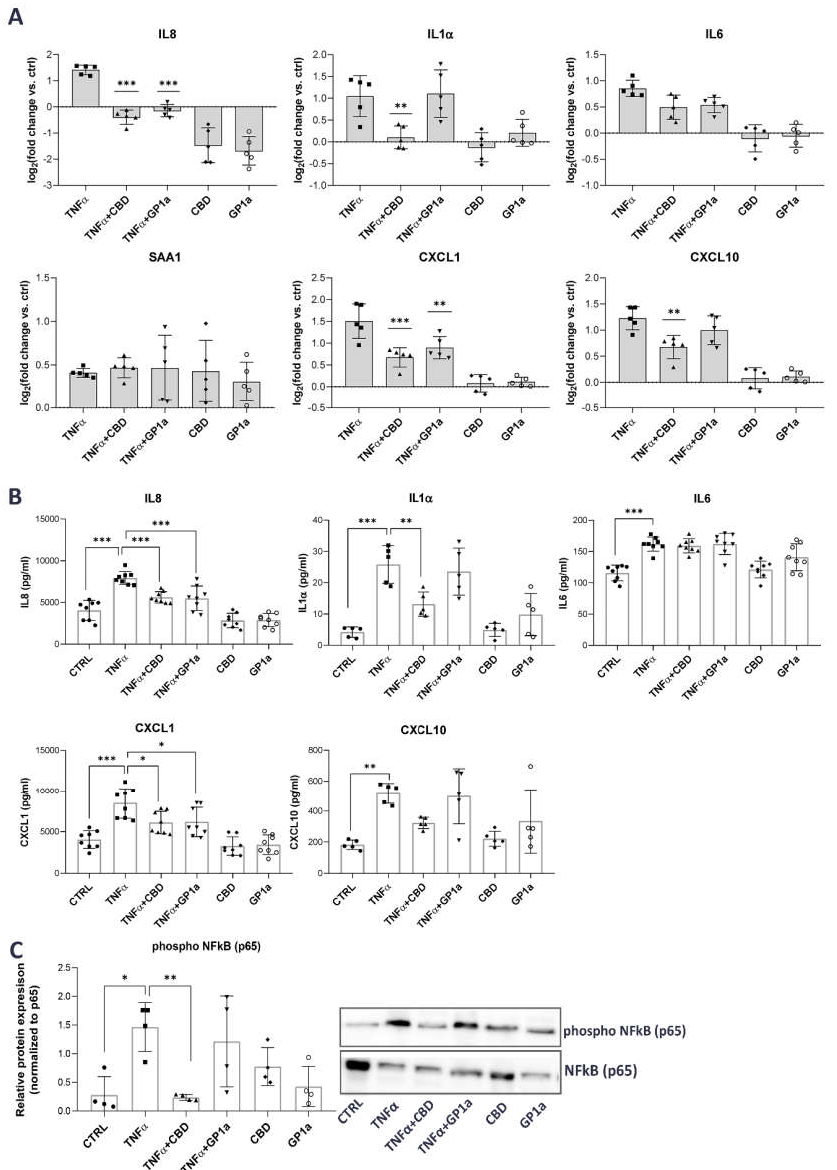
Figure 3. Anti-inflammatory effects of CBD in TNF α -stimulated SV-HUC1 cells. ( A ) mRNA expres- sion of IL8, IL1 α , IL6, SAA1, CXCL1 and CXCL10 in SV-HUC1 cells treated with TNF α (20 ng/mL) in the presence/absence of CBD (5 µ M) or GP1a (5 µ M) for 24 h determined by qPCR. Shown is mean ± SD log2 fold change vs. untreated control (set to 0) determined in five independent experi- ments. ** p < 0.01, *** p < 0.001 vs. TNF α -treated cells. ( B ) Protein levels of IL8, IL1 α , IL6, CXCL1 and CXCL10 released into the supernatants of SV-HUC1 cells treated with TNF α (20 ng/mL) in the presence/absence of CBD (5 µ m) or GP1a (5 µ M) for 24 h determined by ELISA. Shown is mean ± SD of concentrations determined in eight (IL8, IL6, CXCL1) or five (IL1 α , CXCL10) independent experi- ments. ( C ) Protein levels of phosphorylated NF κ B subunit p65 in SV-HUC1 cells treated with TNF α (20 ng/mL) in the presence/absence of CBD (5 µ M) or GP1a (5 µ M) for 24 h determined by western blot. Shown is mean ± SD relative protein expression normalized to the levels of unphosphorylated NF κ B subunit p65 and representative blots of four independent experiments performed. * p < 0.05, ** p < 0.01, *** p <